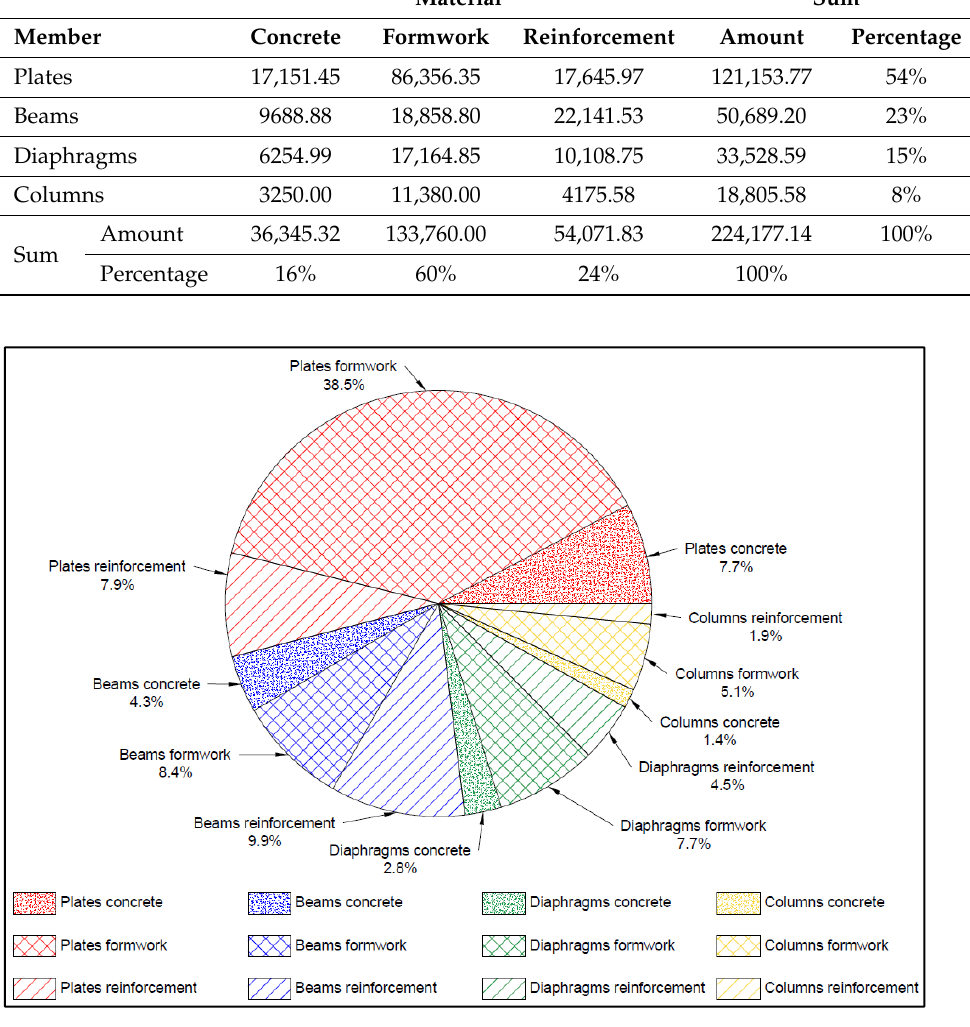
Figure 16. Pie chart of the cost components for the optimum design achieved in the V-type folded plate roof problem.